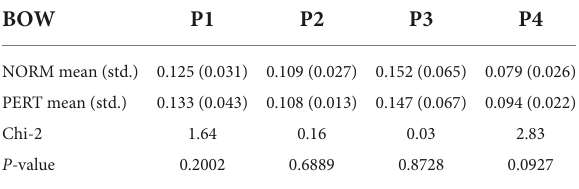
TABLE 2 Power values (db/Hz) extracted from the power spectral density spectra at the four frequency bins that corresponded to musical metrical levels (P1 – P4), compared across experimental conditions for the motion of the bow. BOW P1 P2 P3 P4 NORM mean (std.) 0.125 (0.031) 0.109 (0.027) 0.152 (0.065) 0.079 (0.026) PERT mean (std.)